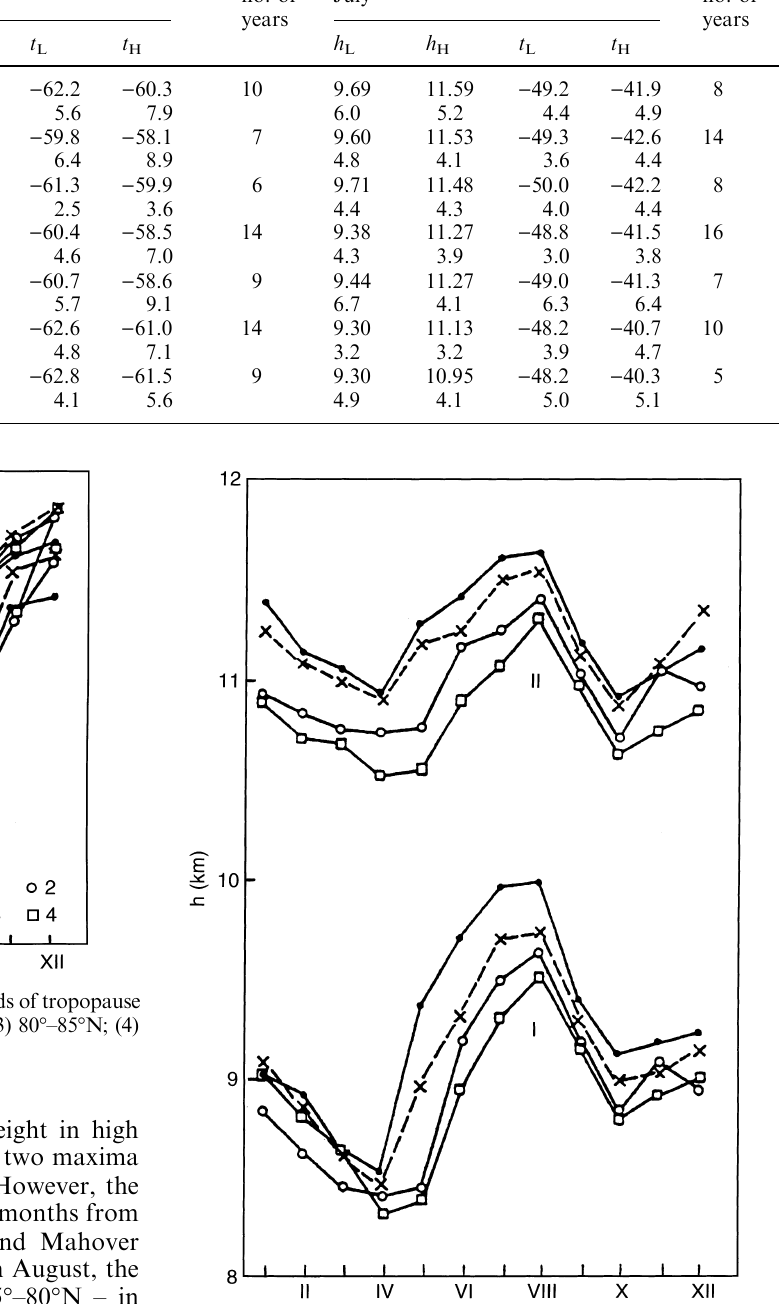
Table 1. Mean values ( X ) of height ( h km) and air temperature ( t (cid:176) C) at the lower (L) and upper (H) tropopause bounds, variation coe(cid:129)cient ( V %) of these parameters coordinates parameter